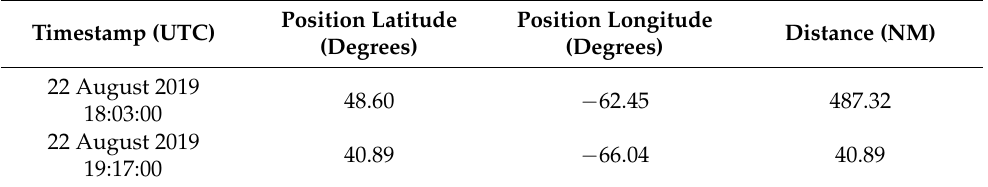
Table 1. An example of a position